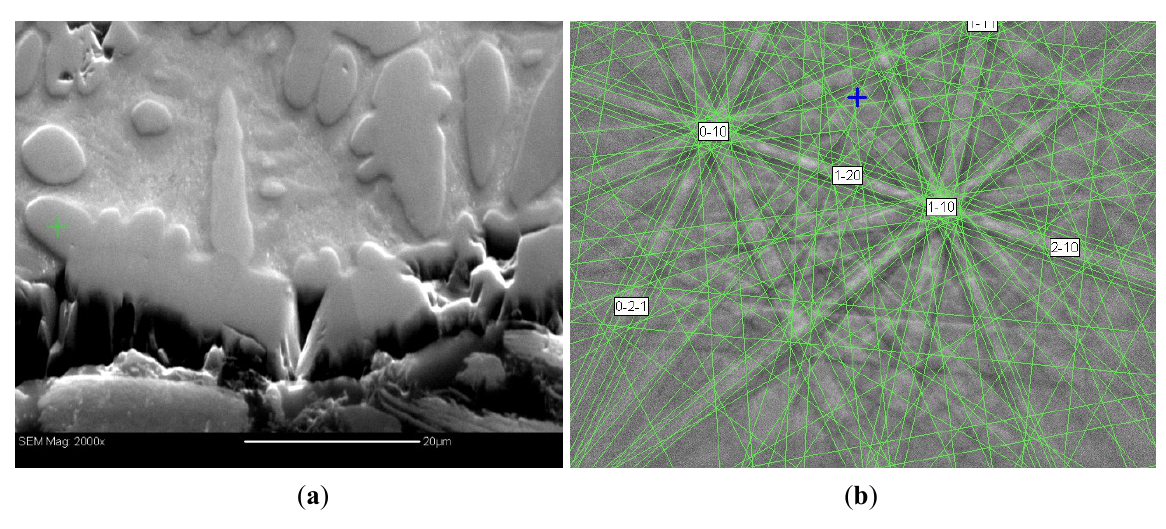
Figure 12. ( a ) Scanning electron micrograph of the nitrided surface layer of sample No.